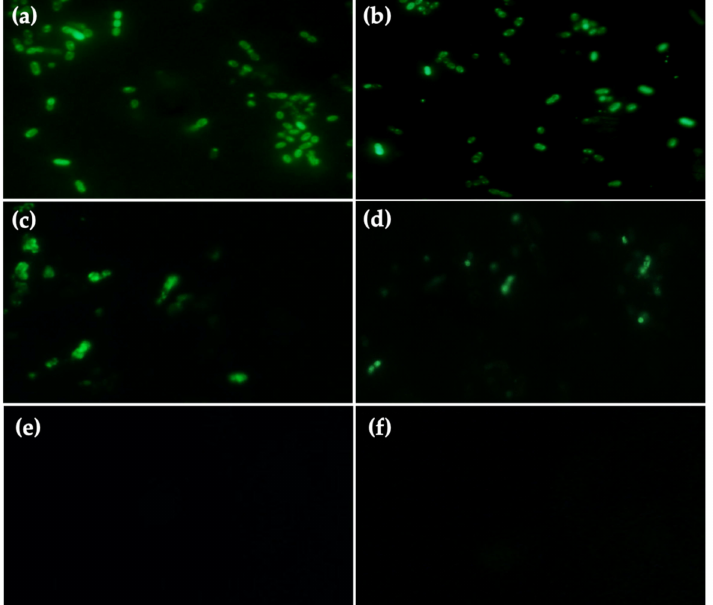
Figure 4. Fluorescence of recombinant L. lactis labeled with (Flourescien-5-isothiocyanate) FITC- conjugated antigens. The anti-FaeG and anti-FedF L. lactis strains specifically recognized FITC labeled FaeG and FedF antigens, respectively, as shown by fluorescence microscopy. Slides: ( a ) anti-FaeG Nb L. lactis (pEXP368) labeled with FaeG-FITC; ( b ) anti-FaeG L. lactis (pEXP366) labeled with FaeG- FITC; ( c ) anti-FedF L. lactis (pEXP364) labeled with FedF-FITC; ( d ) anti-FedF L. lactis (pEXP362) labeled with FedF-FITC; ( e ) non FaeG/FedF L. lactis (pEXP242) labeled with FaeG-FITC; ( f ) non FaeG/FedF L. lactis (pEXP242) labeled with FedF-FITC. Image captured at X100 magnification under oil